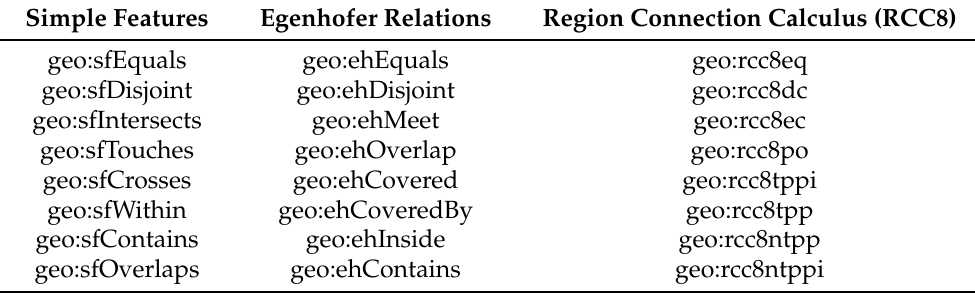
Table A1. GeoSPARQLTopologicalRelationsasdefinedintheGeoSPARQL1.0standard. Thethreecolumns reflect the order of standardization and not the order of relation between the given